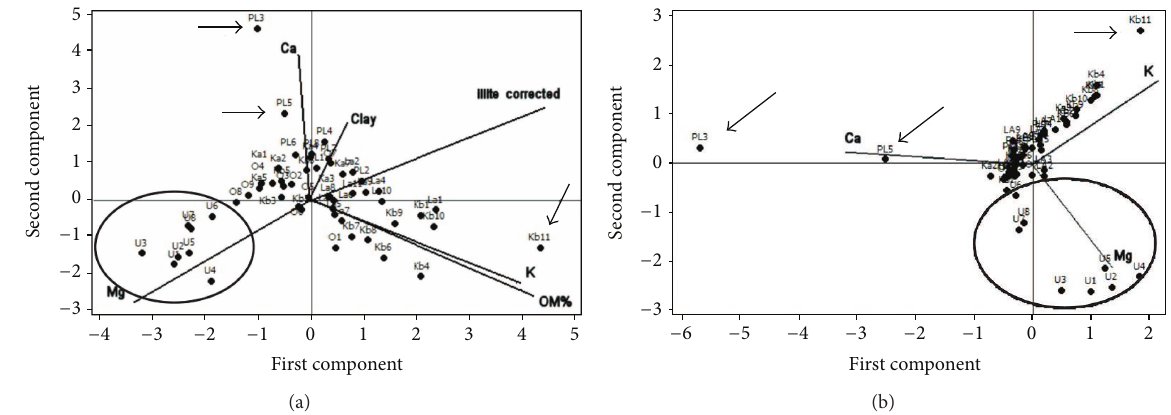
Figure 3: (a) PCA analysis of macronutrients availability (Ca 2+ , Mg 2+ , and K + ) and physical characteristics (clay content: clay%, organic content: OC%). (b) PCA analysis of macronutrients availability (Ca 2+ , Mg 2+ , and K + ). 54 soil samples included from Omalos Plateau (O), Lasithi Plateau (La), Kantanos (Ka, Kb) Anogia (U), and Platanos (PL). The variable axes are depicted in the figure.